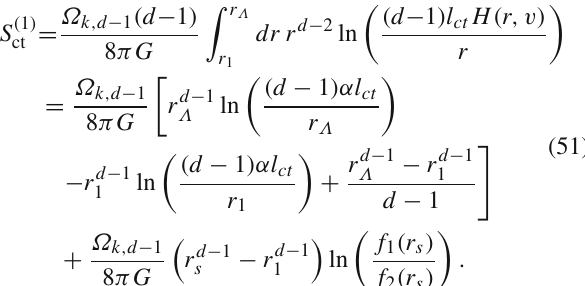
Whence, the counterterm contribution for the past null boundary on the right side can be written